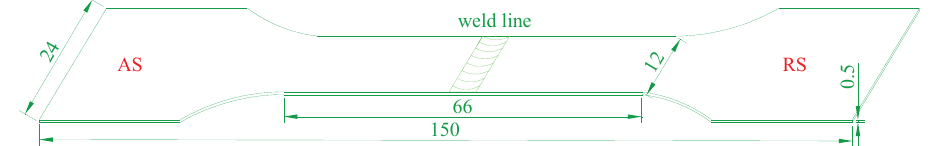
Figure 2. ( a ) Size of the microwelding tool, ( b ) Welding assembly diagram.